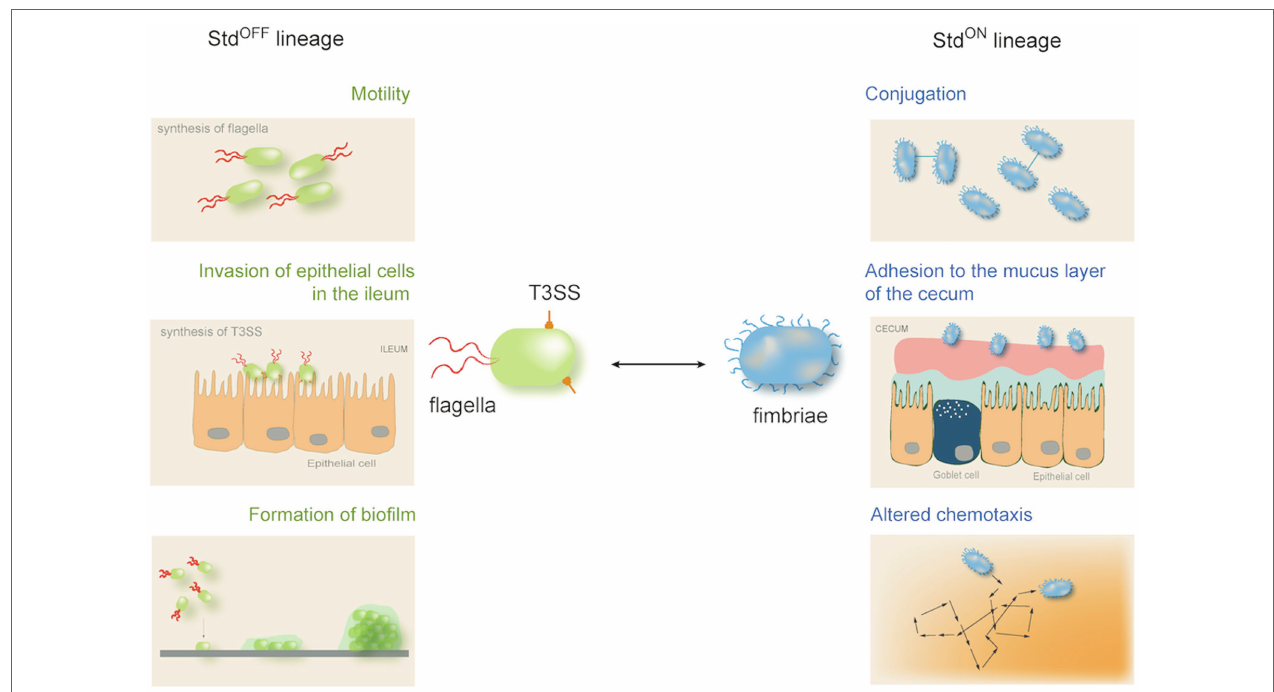
FIGURE 4 | Subpopulation formation under the control of the Std pleiotropic switch in Salmonella enterica serovar Typhimurium. In addition to fimbriae, the std operon encodes transcriptional regulators that activate or repress hundreds of genes. As a consequence, the Std OFF and Std ON lineages differ in multiple phenotypic